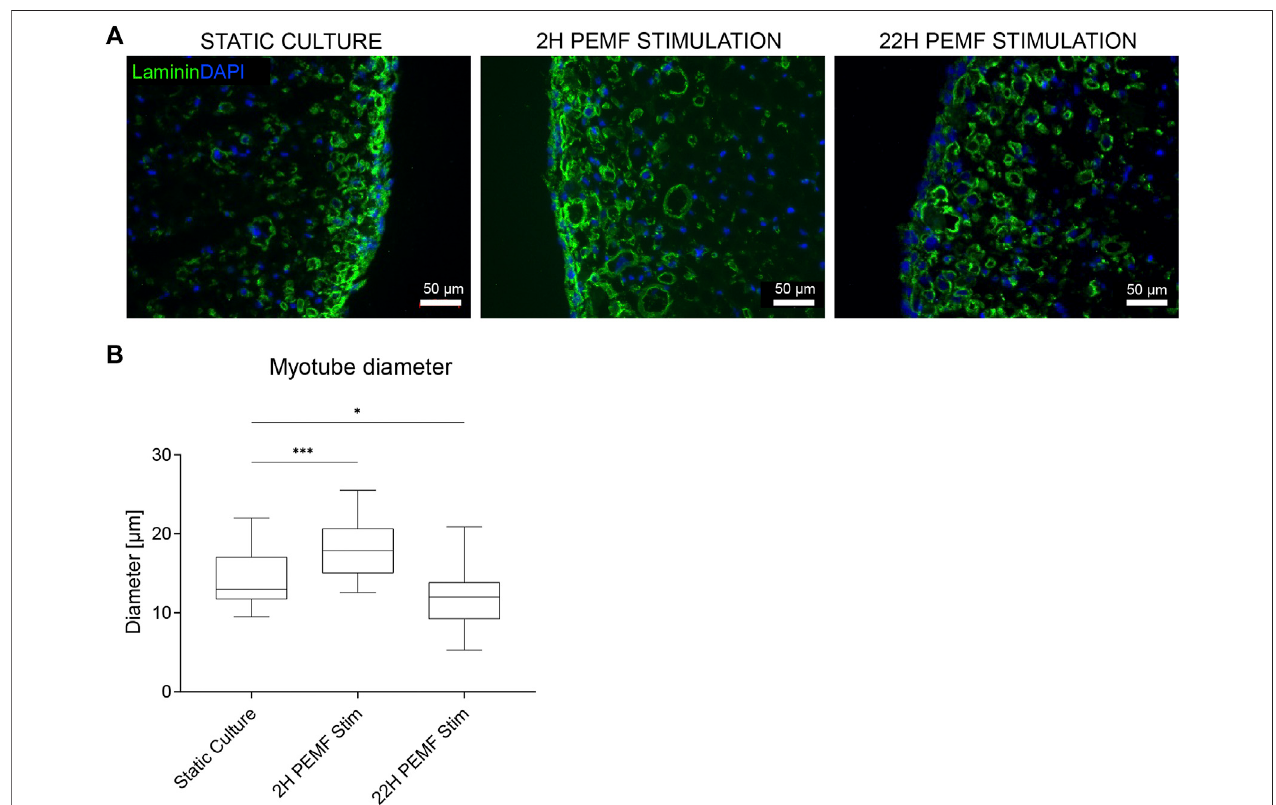
FIGURE 3 | (A) Laminin staining of the 3D samples. Blue: nuclei stained with DAPI; green: myotubes stained for laminin. Scale bars: 50 µm. (B) Myotube width quanti fi cationsfromthelamininstainingimages via Fijisoftware.( n =6BAMs,foreach3imagesquanti fi ed,*** p < 0.001).Theboxplotrepresentsthemedian,5and95%